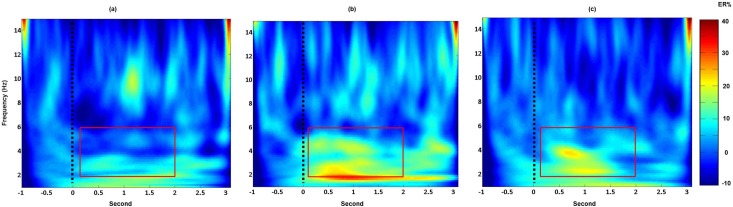
EEG-power change after olfactory, trigeminal and control stimulation (condition D).Displayed are the Cz EEG-power changes (group average including the 10 participants) after control (a), olfactory (b) and trigeminal (c) stimulation. The dashed black line marks the stimulus onset. An increase in low frequency within the ROI (red square) can be observed in b and c but not in a. The scale displays EEG-power change in percent compared to the pre-stimulus interval.